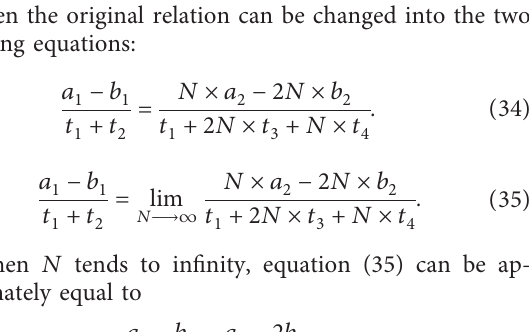
Figure 6: The number of boarding points opened in different periods.